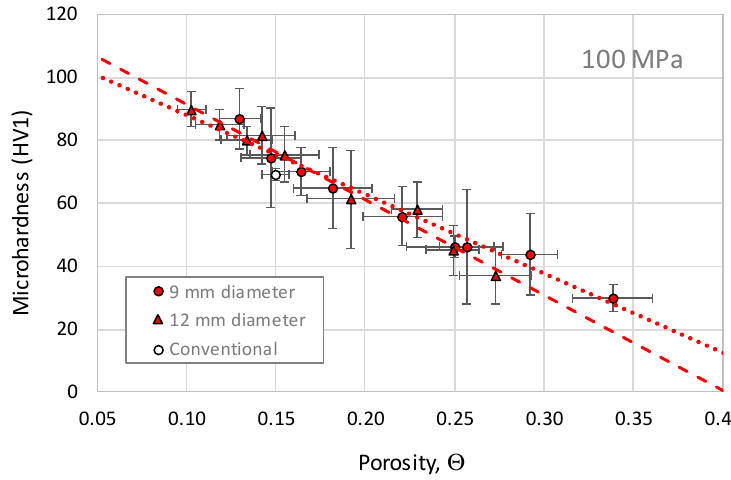
Figure 10. Mean microhardness versus porosity ( Θ ) in experiments carried out with 100 MPa of applied pressure and the same current densities and powder mass, but different inner diameters of the die (9 and 12 mm). Lines represent the trend of the two sets of points.